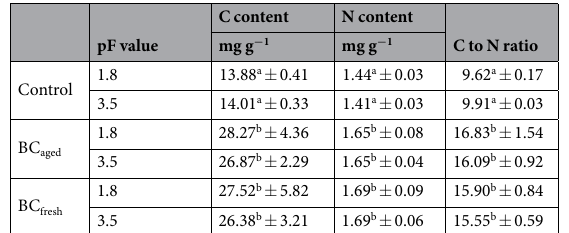
Table 2. Mean C contents, N contents and C to N ratios of bulk soils (n = 18) from 0 days to 90 days of